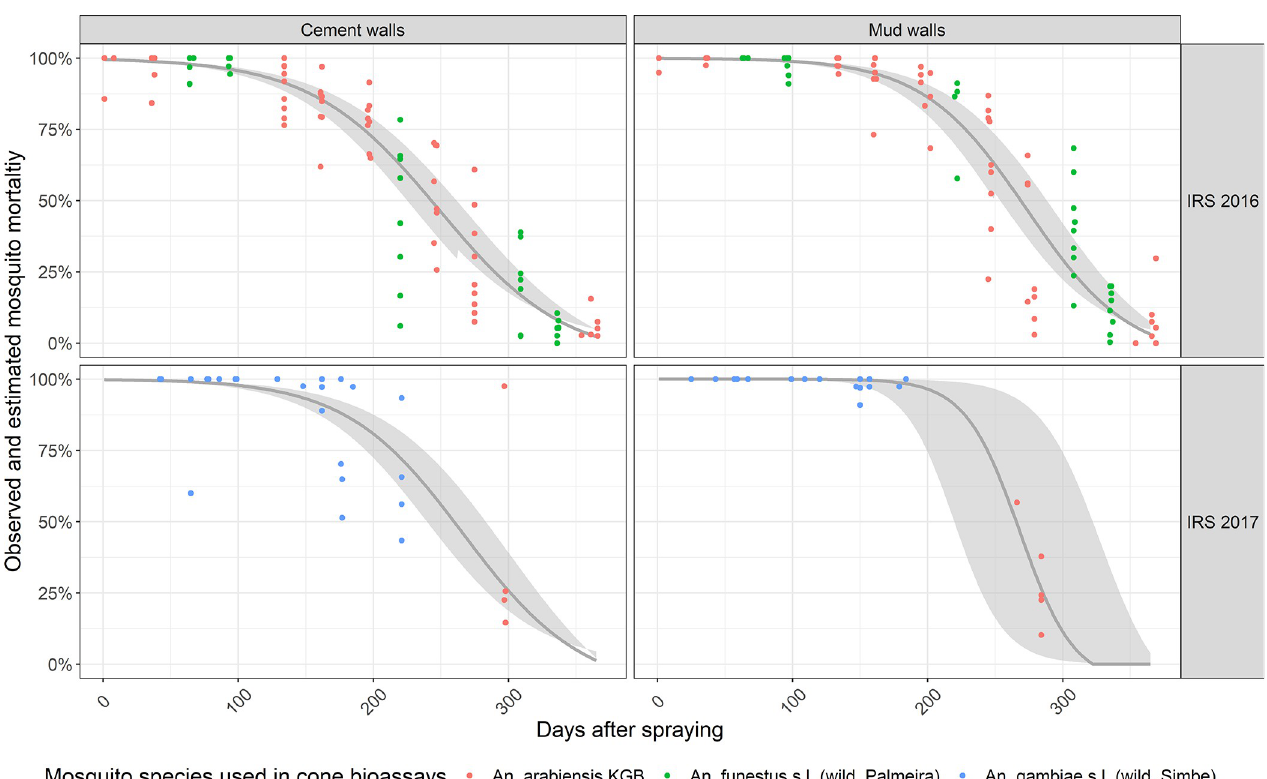
Fig 2. Residual efficacy of Actellic 1 300CS in Magude on two different wall types after the 2016 and 2017 IRS campaigns in Magude district. Observed (point data, after Abbott’s correction) and estimated (lines) mosquito mortality 24h post-exposure to insecticide-treated mud/clay-plastered and cement walls. Point colors represent the species of mosquitoes used in cone bioassays at each point in time ( An . arabiensis KGB colony mosquitoes, wild-caught An . funestus s . l . or wild-caught An . gambiae s . l .).